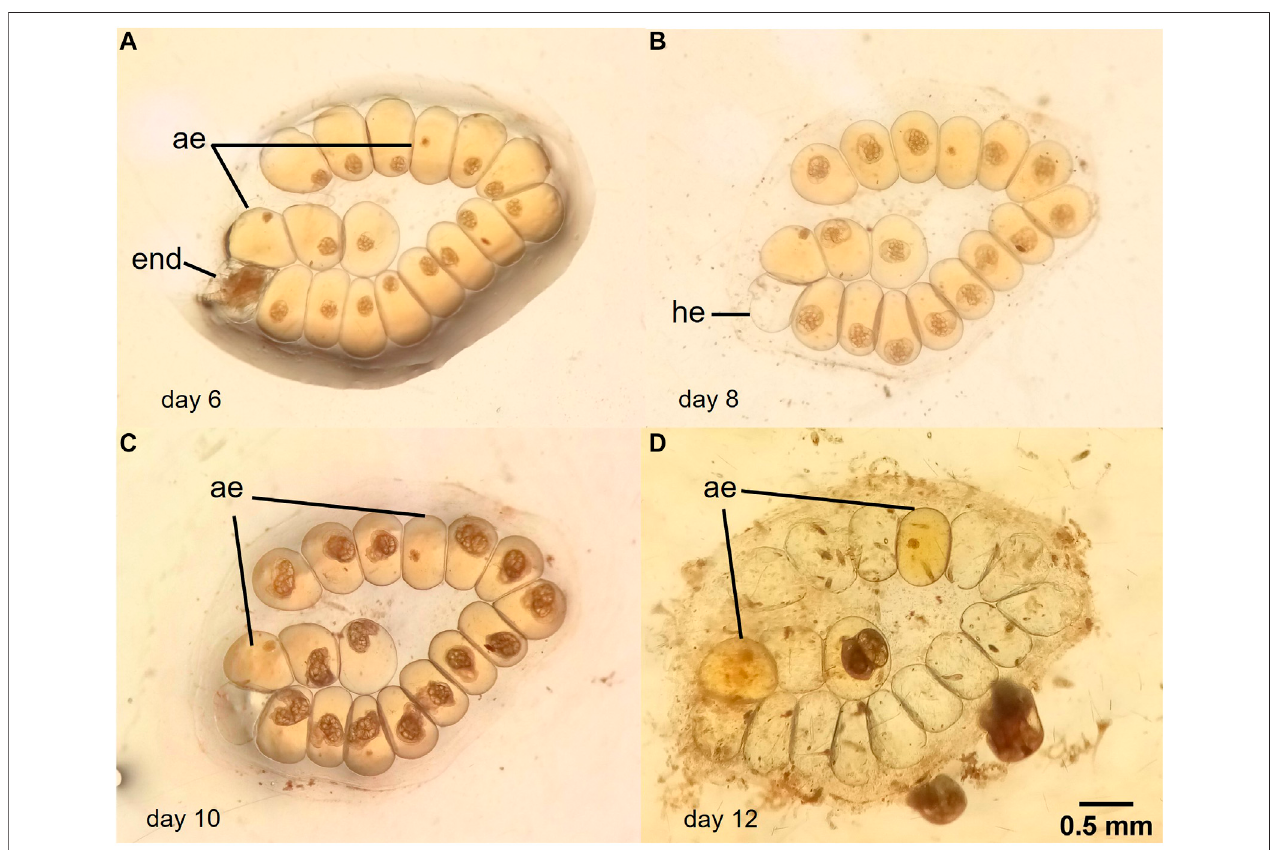
FIGURE 4| Photographs ofan eggmassof Biomphalaria straminea at different stages of developmentof the embryos. The egg mass was exposed to water from siteL2,LuganoLake. (A) :day6ofembryosdevelopment, (B) :day8, (C) :day10, (D) :day12.ae:arrestedeggs;end:embryonormaldevelopment;ae:arrestedegg;he: hatched egg.